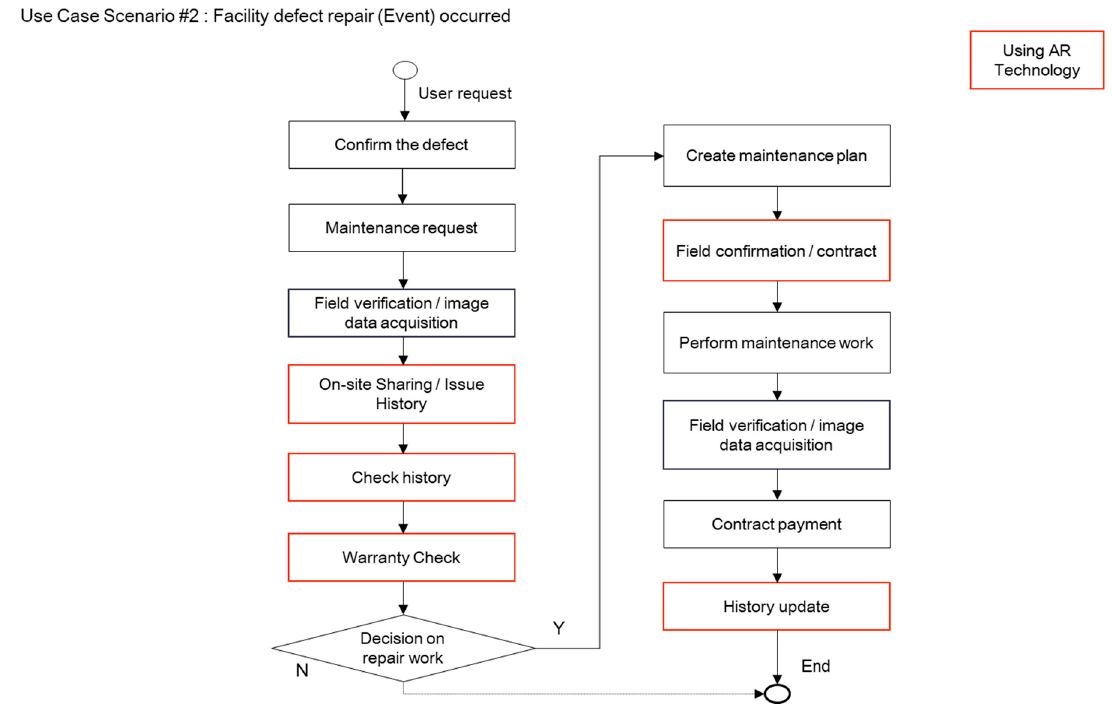
Figure 5. Detailed tasks scenario upon receiving a defect report.